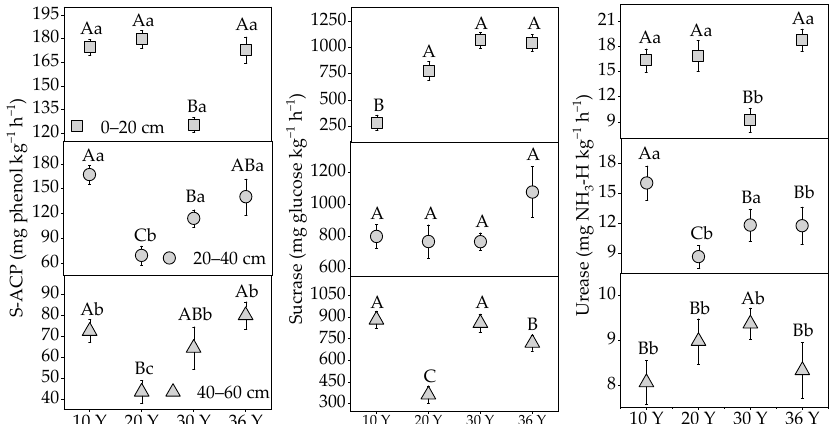
Figure 4. Soil enzyme activities of different ages and soil depths. S-ACP: soil acid phosphatase. 10 Y: 10-year stand; 20 Y: 20-year stand; 30 Y: 30-year stand; 36 Y: 36-year stand; 0–20 cm: 0–20 cm soil depth; 20–40 cm: 20–40 cm soil depth; 40–60 cm: 40–60 cm soil depth. The values show means ± SE. Different capital and lowercase letters represent differences among different stand ages and soil depths, respectively ( p < 0.05).